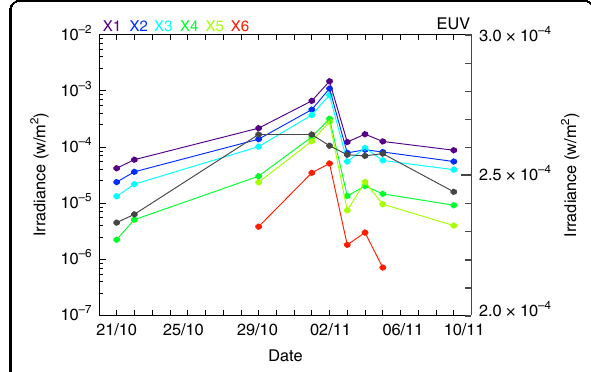
Fig. 1 Solar irradiance variations measured by X-EUVS. EUV (black): 19.5 nm, X1: 0.6 – 8.0 nm, X2: 0.6 – 6.0 nm, X3: 0.6 – 5.0 nm, X4: 0.6 – 2.0 nm, X5: 0.6 – 1.6 nm, and X6: 0.6 – 1.2